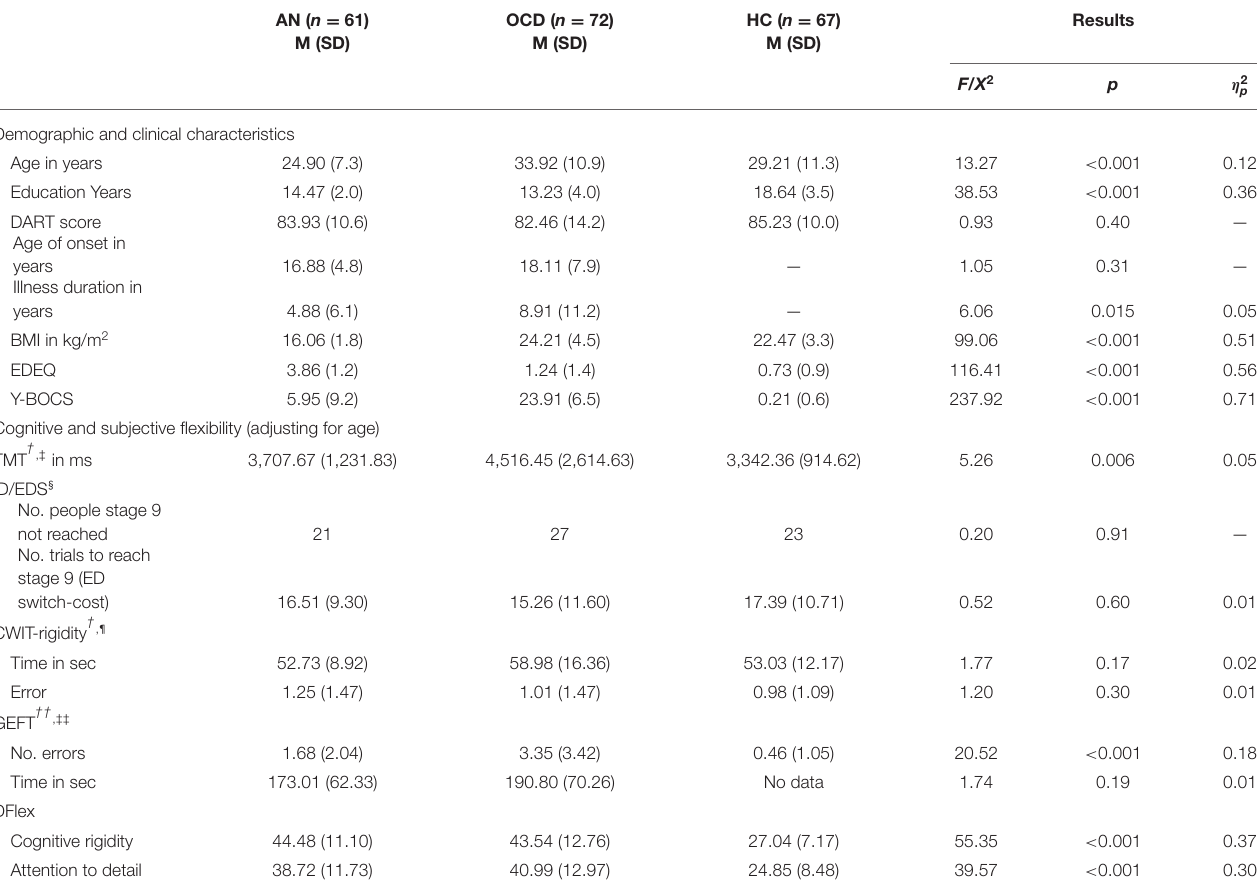
TABLE 1 | Mean, SD and between group differences for demographic, clinical and flexibility variables of all